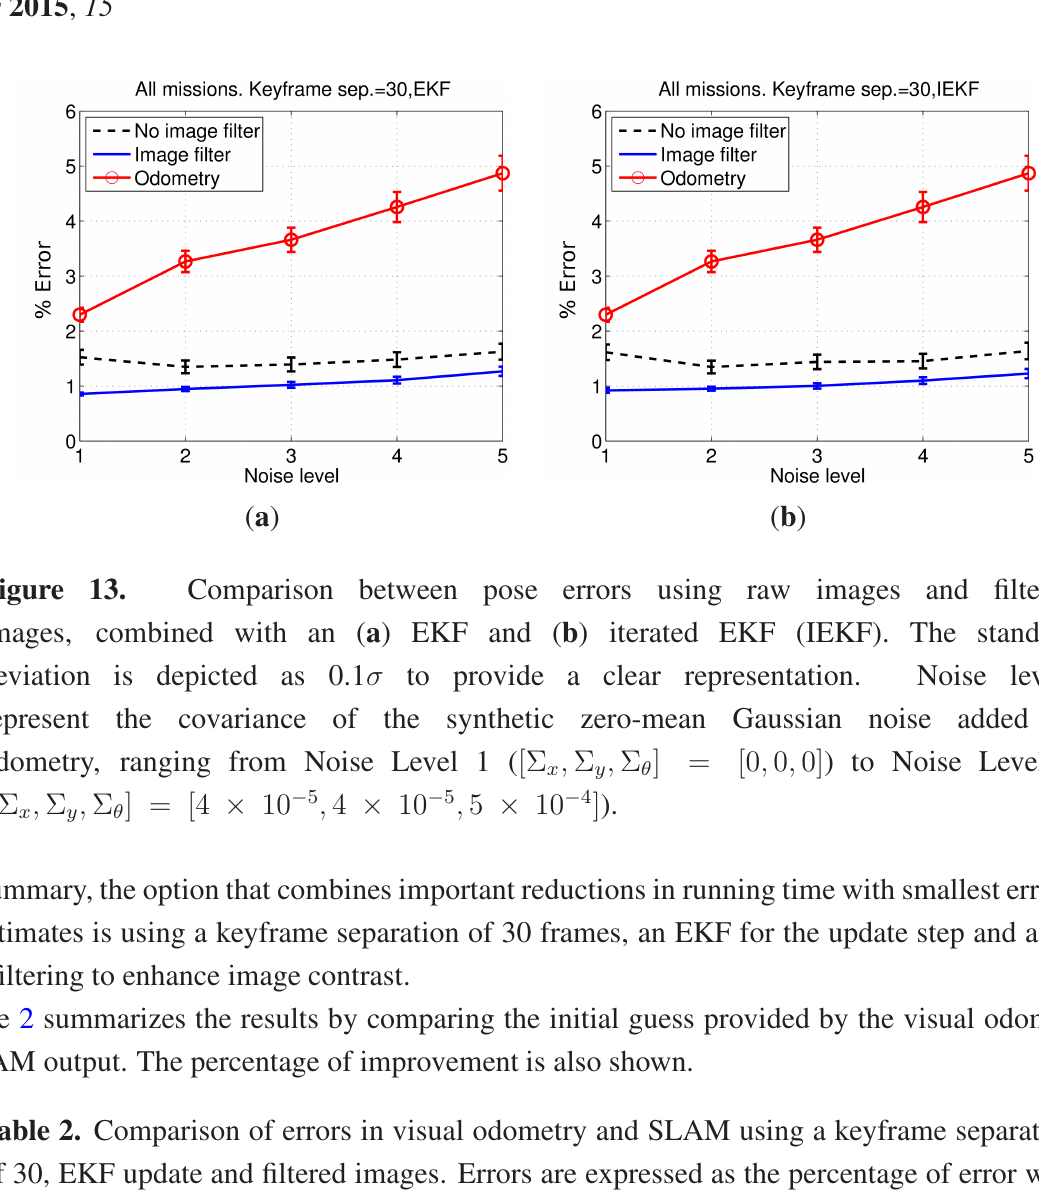
, Σ , Σ ] = [0 , 0 , 0] ) to Noise Level 5 x y θ